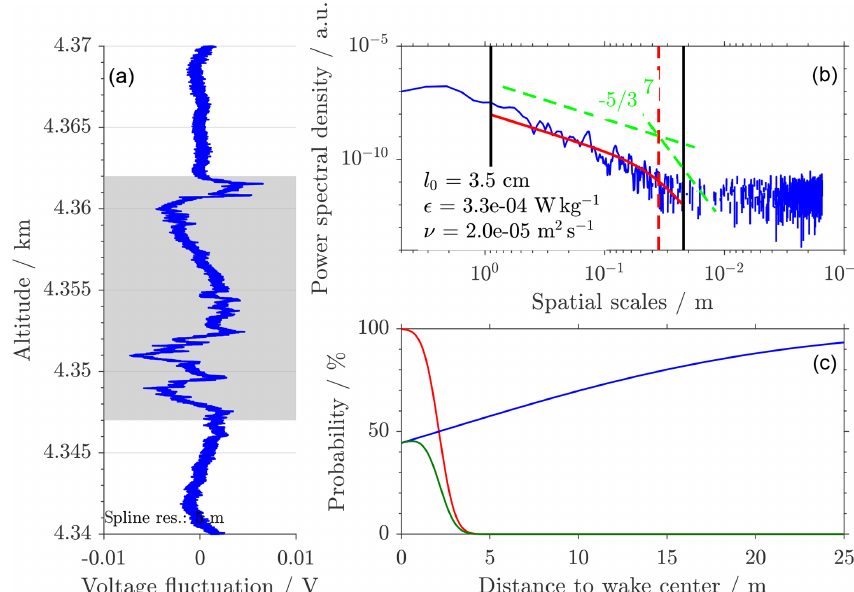
Figure 3. Example for turbulence caused by the balloon’s wake from a LITOS launch on 29 January 2016. (a) Raw data from the CTA, grey shaded area influenced by wake. (b) Turbulence retrieval fit as in Fig. 1 from the data shown in the shaded area. (c) Result from the wake prediction algorithm for the same altitude. Blue shows the probability distribution of the payload–wake distance d p-wake to be in the range of [ 0 ,d ] after Eq. (12). Red shows the radial probability distribution of the wake after Eq. (13). Green shows the combined probability for wake encounter P wake according to Eq.